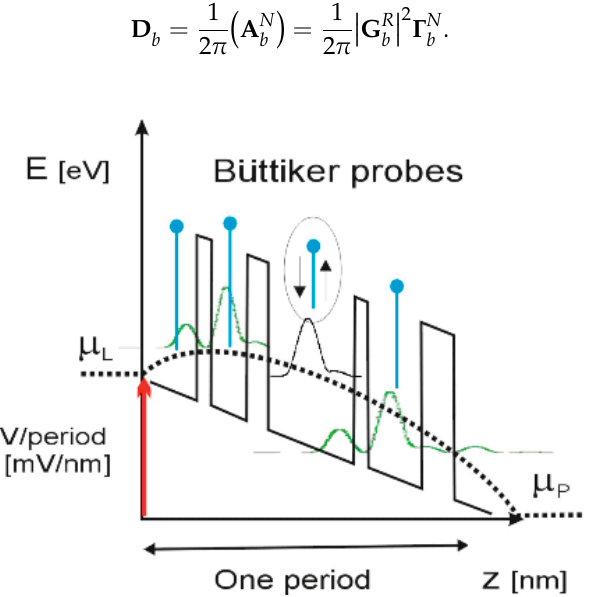
Figure 7. A schematic illustration of the idea of Büttiker probes. A virtual electrode is attached to each localized quantum state to exchange charge with the electrons reservoir.